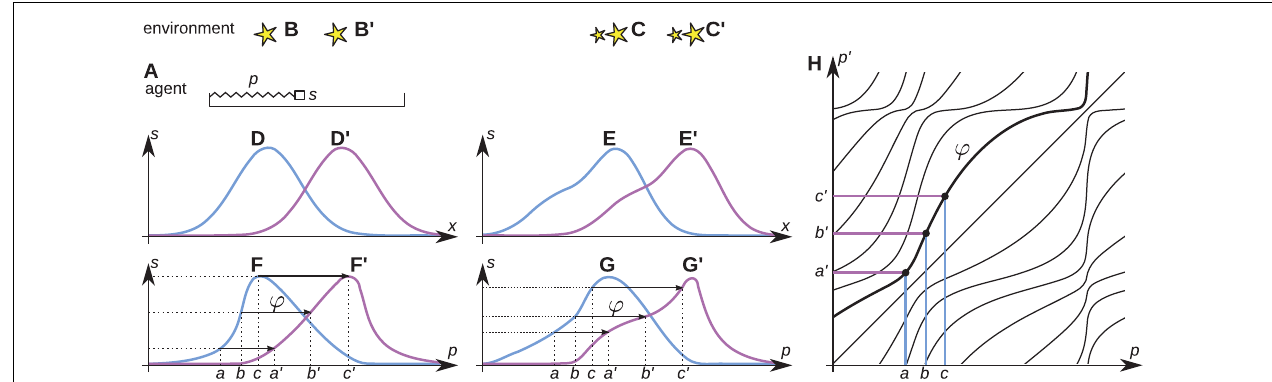
FIGURE 1 | Algorithm of space acquisition illustrated with a simplified agent . The agent (A) has the form of a tray, inside which a photoreceptor s moves with the help of a muscle, scanning the environment (B) composed of scattered light sources. The length of the muscle is linked to the output of the proprioceptive cell p in a systematic, but unknown way. The output of the photoreceptor depends on its position x in real space (D) . The agent learns the sensorimotor contingency (F) linking p and s . After a rigid displacement of the agent, or a corresponding displacement of the environment from (B) to (B ′ ) , the output of the photoreceptor changes from (D) to (D ′ ) and a new sensorimotor contingency (F ′ ) is established. For a sufficiently small rigid displacement, the outputs of the photoreceptor will overlap before and after the displacement. The agent makes a record of the corresponding proprioceptive values between the sensorimotor contingency (F,F ′ ) (arrows from a , b , c to a ′ , b ′ , c ′ ) and constructs the function p ′ = φ ( p ) [ (H) , bold line]. Different functions φ [thin lines in (H) ] correspond to different rigid displacements. If the agent faces a different environment (C) and makes a rigid displacement equivalent to its displacement to (C ′ ) , the outputs of the photoreceptor change from (E) to (E ′ ) and the corresponding sensorimotor contingency changes from (G) to (G ′ ) . Yet, because of the existence of space, the same function φ links (G) to (G ′ ) . The tests in Figures 3 – 6 show that the functions φ constitute the basis of spatial knowledge. Reproduced with permission from Terekhov and O’Regan (2014) © 2016